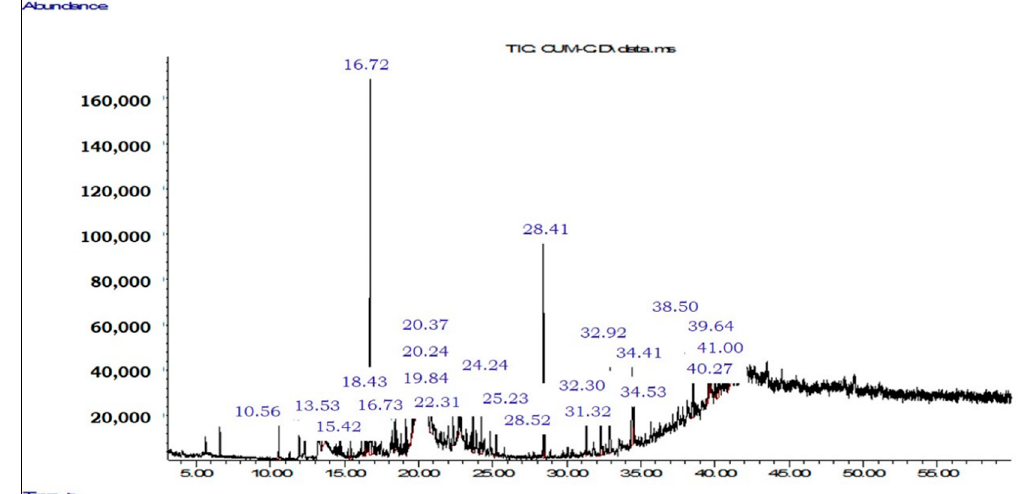
Figure A6. Dipteryx punctata husks extract chromatogram.